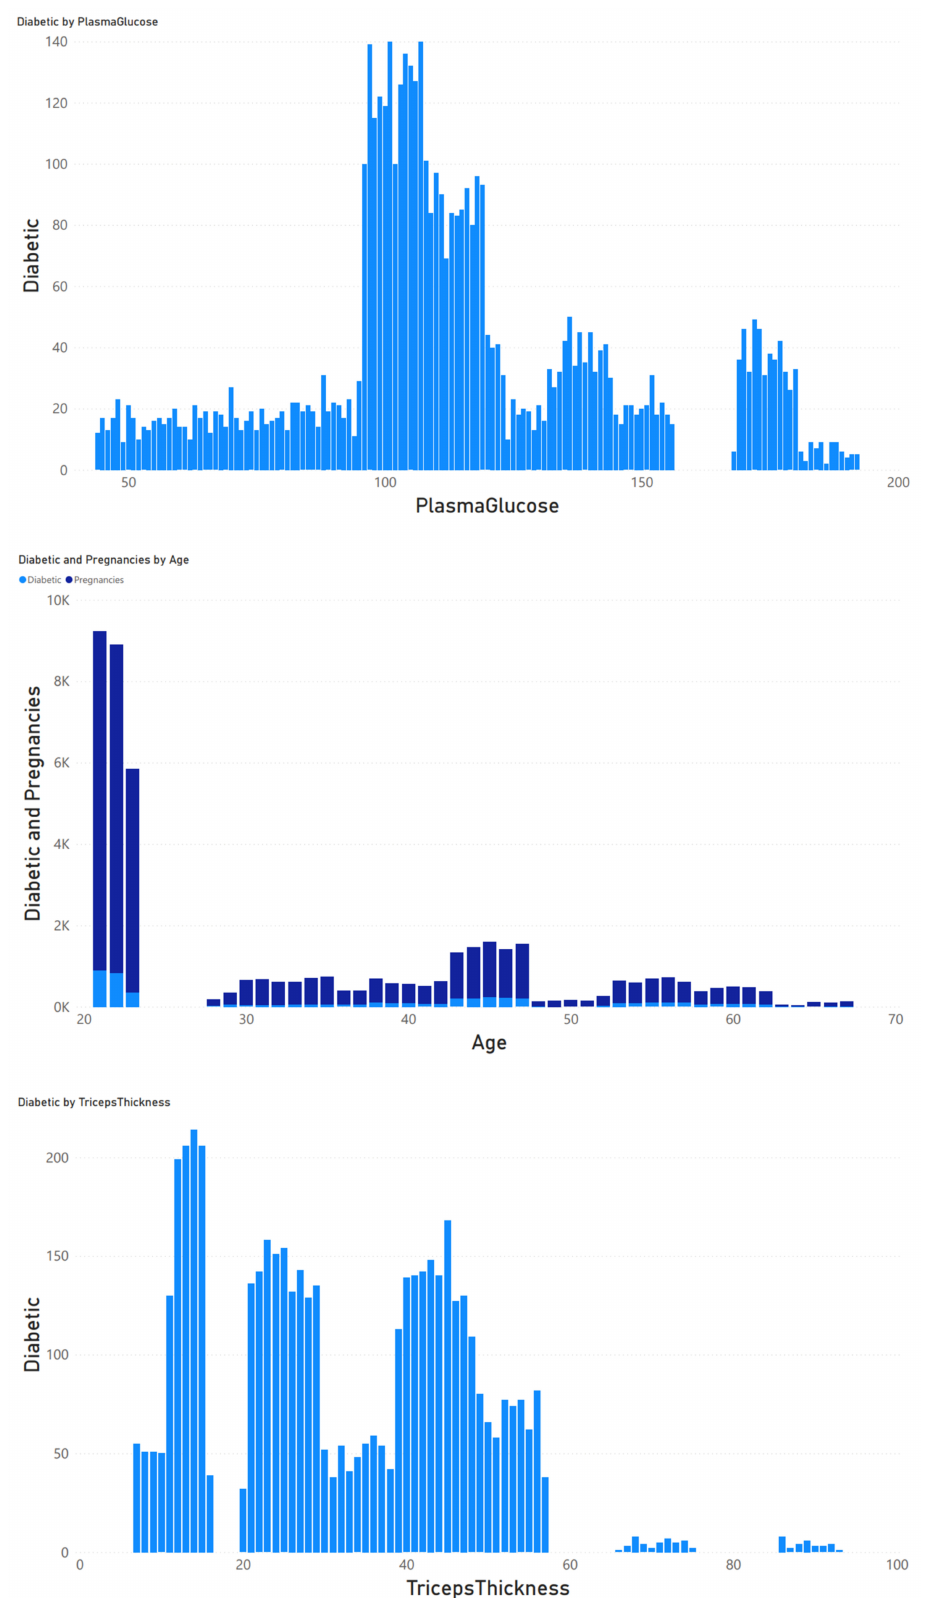
Figure 4. Correlation between diabetes and all